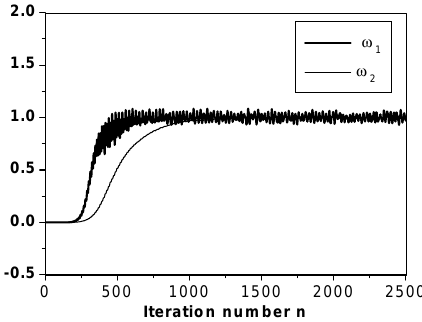
Fig. 22. Evolution of the normalized filter coefficients (transform-domain LMS ), case ( C 5